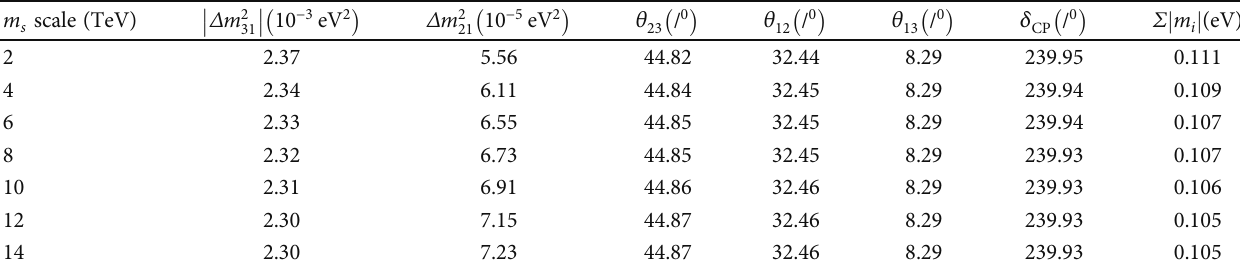
for IH case ( tan β = 40 , M s